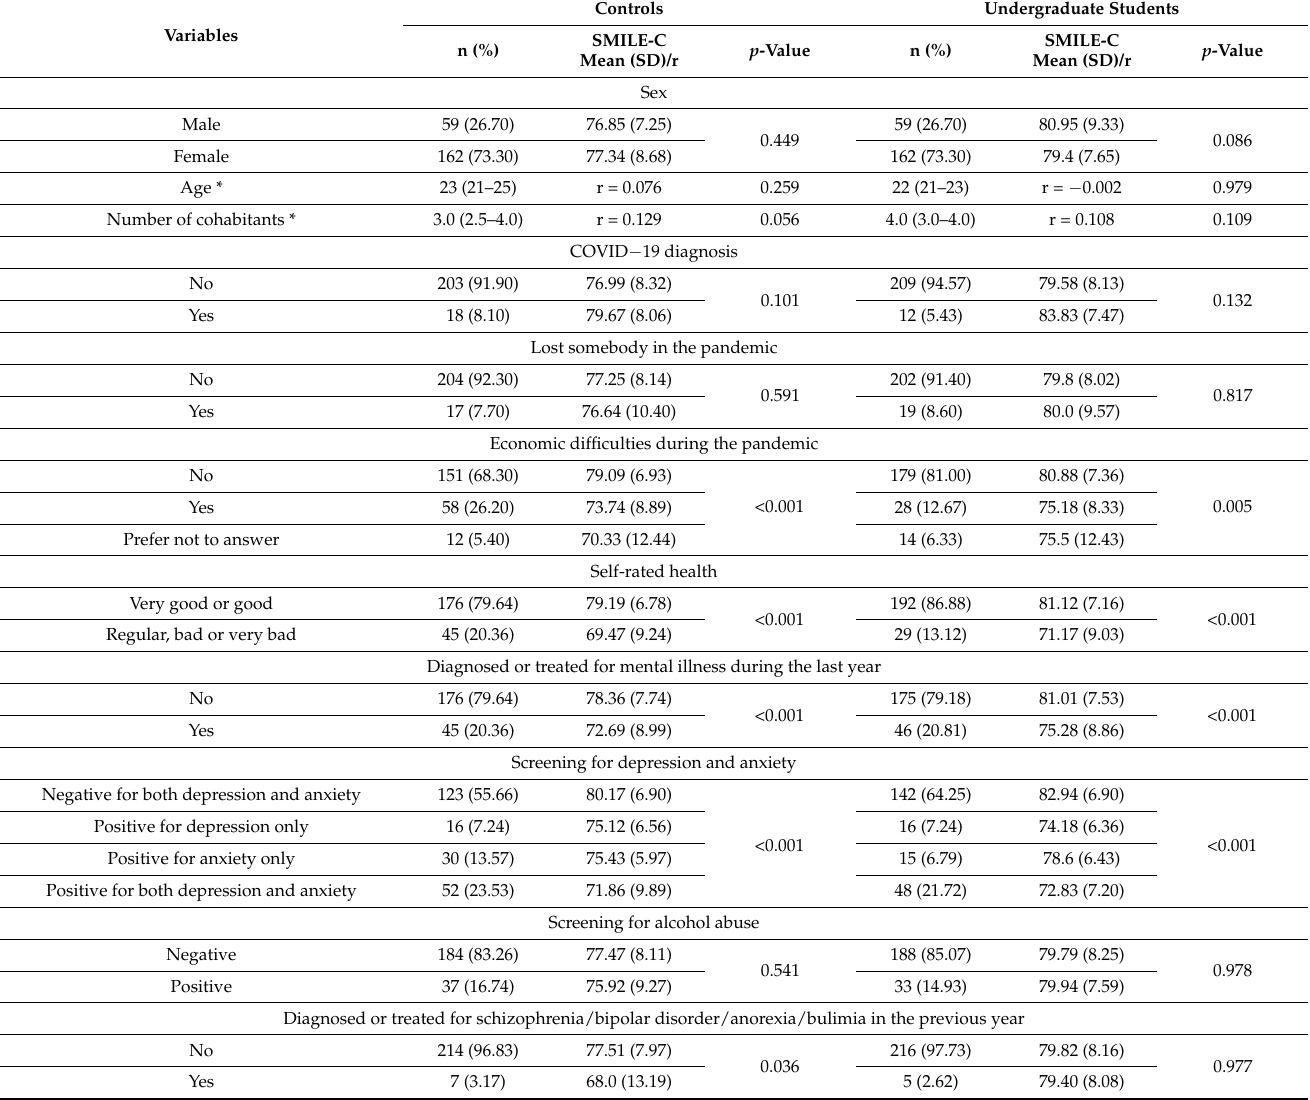
Table 1. Sociodemographic, COVID-19 related experiences, health-related variables and mean SMILE-C score. Variables